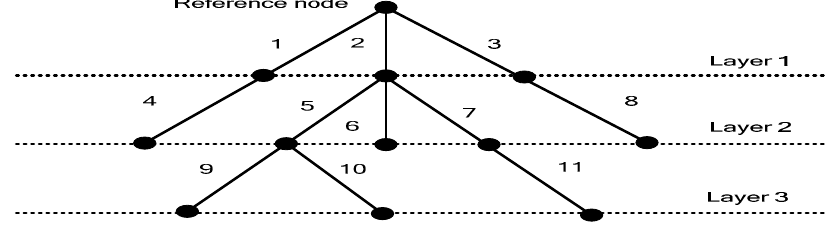
Figure 5. Layers in the radial distribution network (RDN).